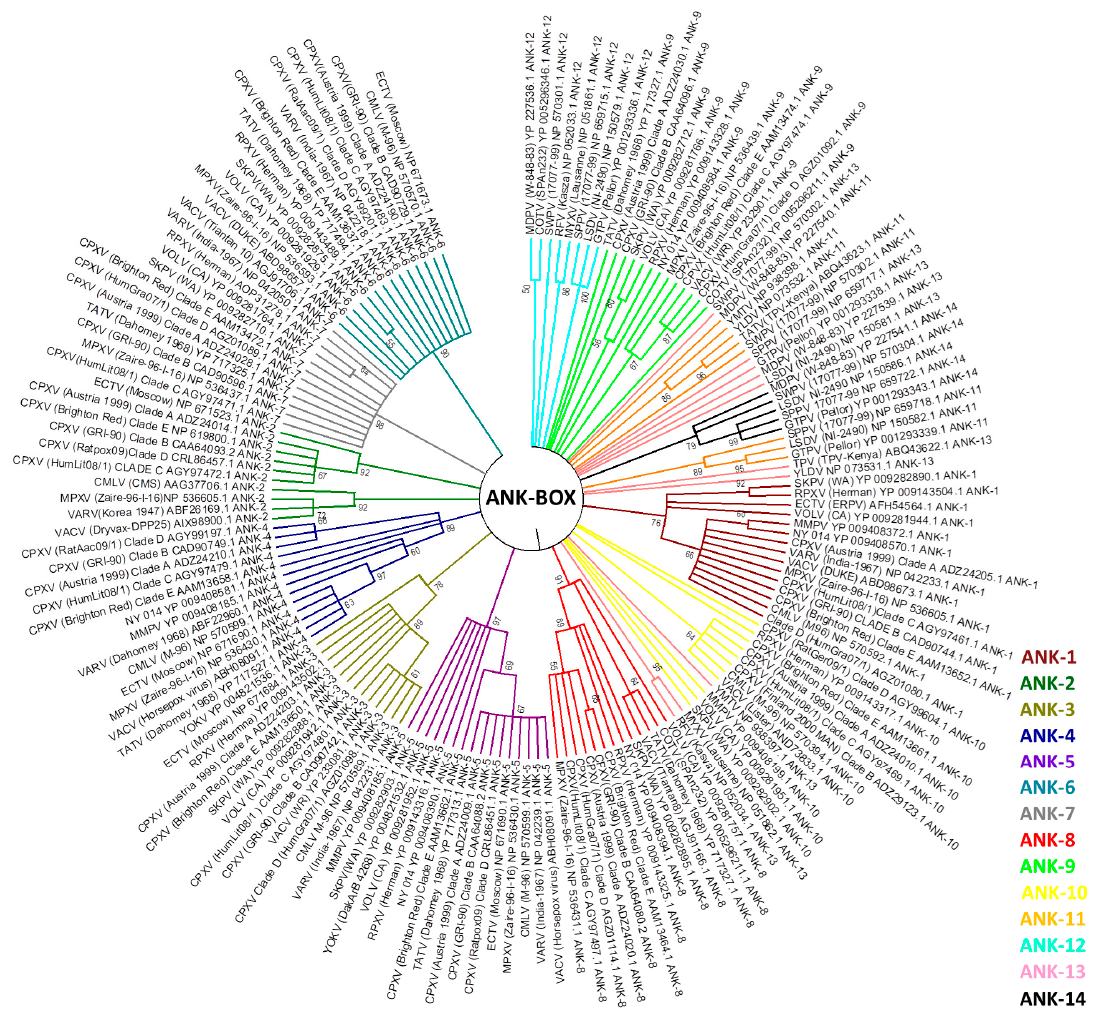
Figure 3. Presence of Ank-box host range gene projected onto a tree showing the phylogenetic relationships of representative poxvirus strains. The tree was generated from a multiple protein sequence alignment of the indicated sequences using the maximum likelihood method. A bootstrap of 1000 was used, and support >50 is indicated above the branches.